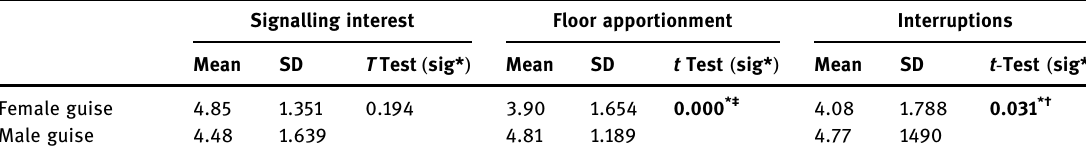
Table 4: Respondents ’ impressions of speaker A in the conversation depending on guise